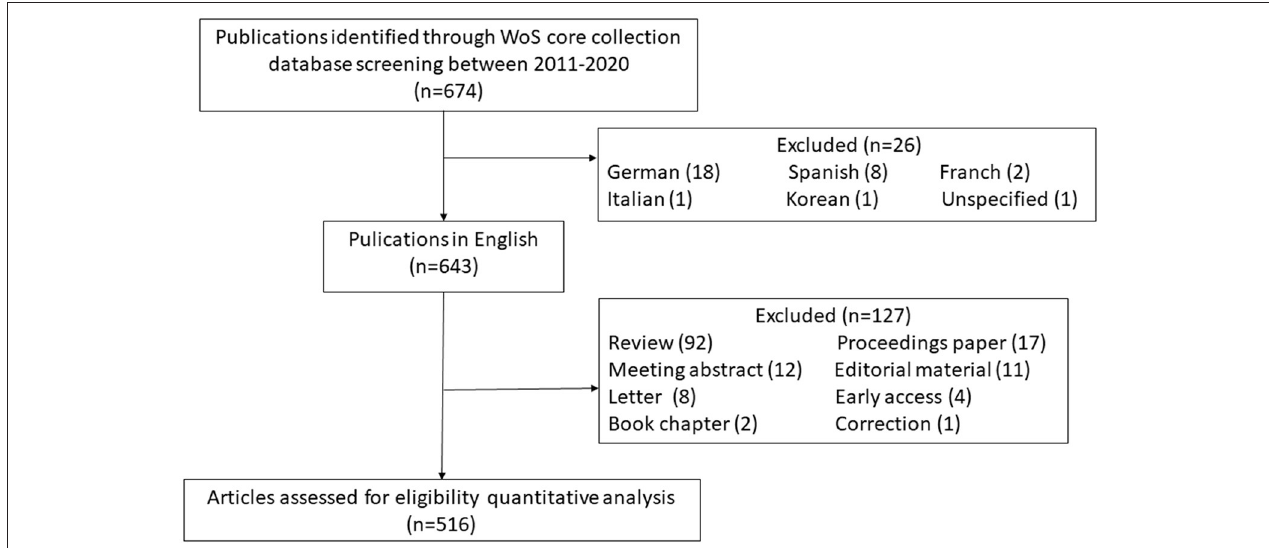
FIGURE 1 | Flow diagram of included publications. WoS, web of